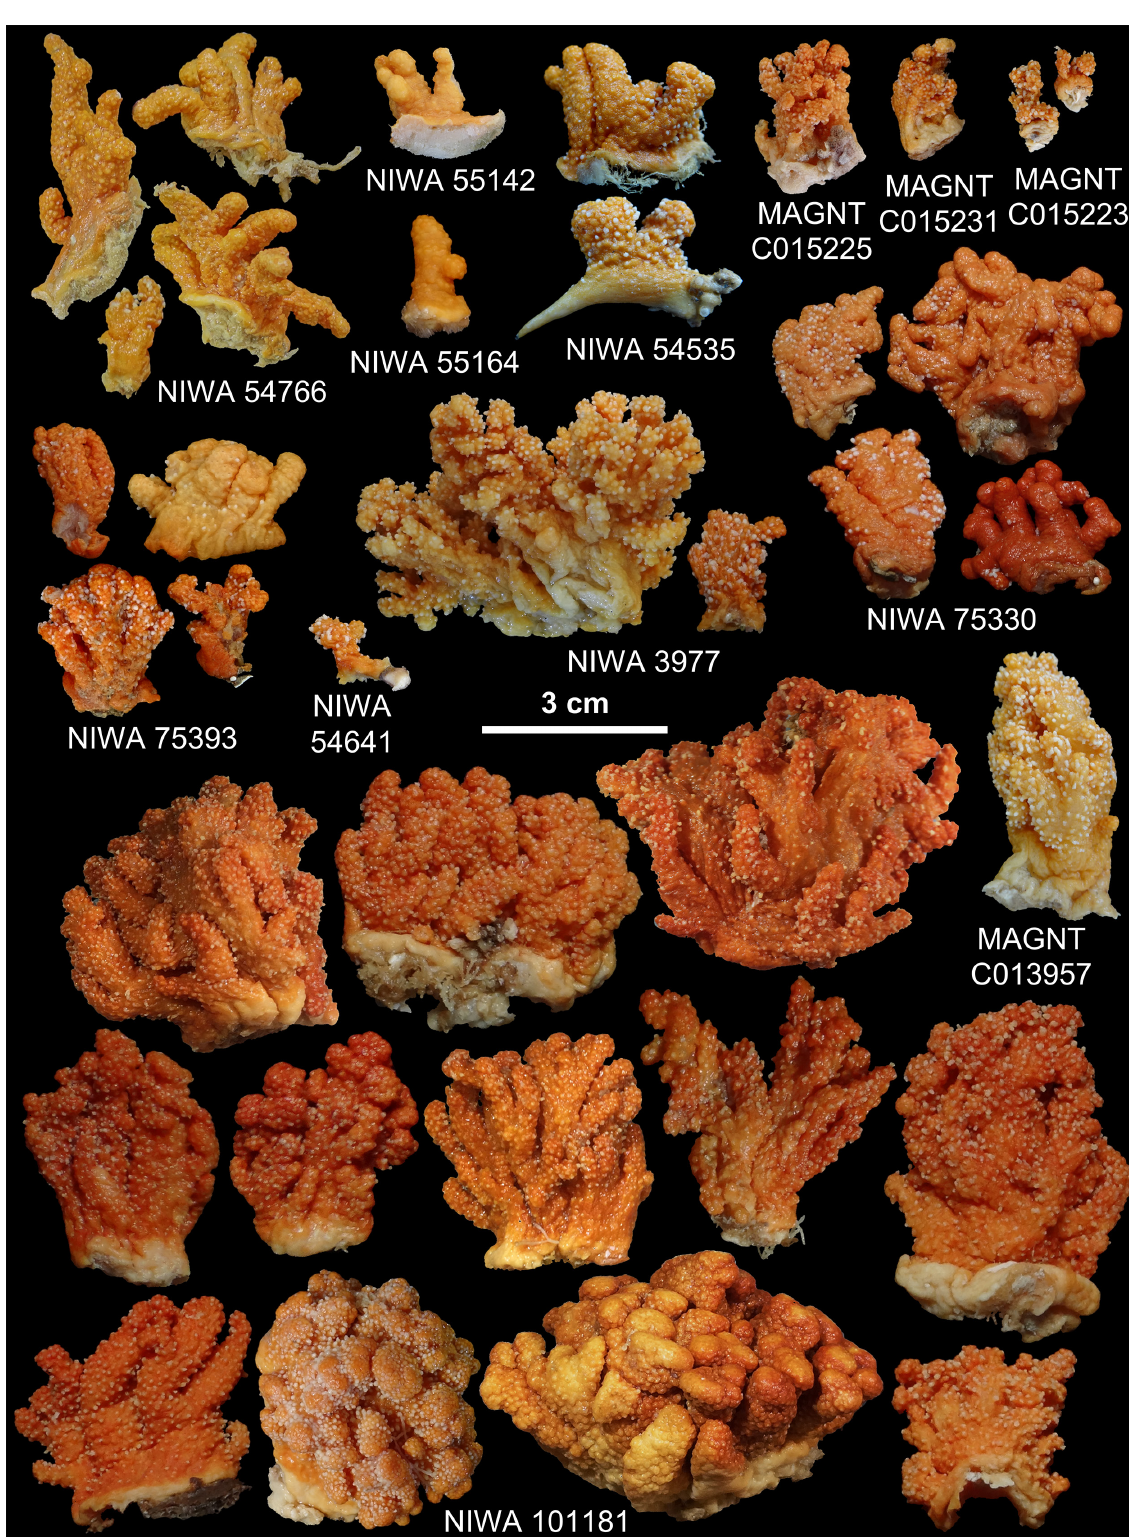
Fig. 8. Selected preserved specimens of Kotatea aurantiaca gen. et comb. nov. Note that most specimen lots include small additional fragments that are not depicted and NIWA 101181 comprises a total of 67 similar colonies, all of which were